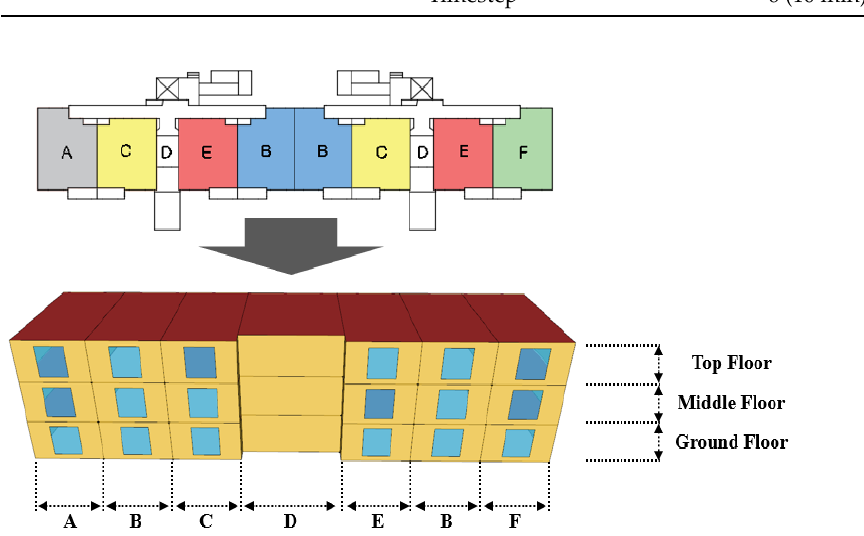
Figure 3. Overall view of the case-study model.